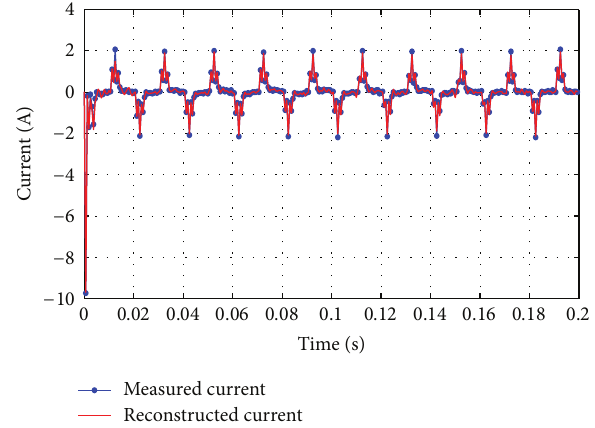
Figure 8: The measured and reconstructed currents of the economy lamp.